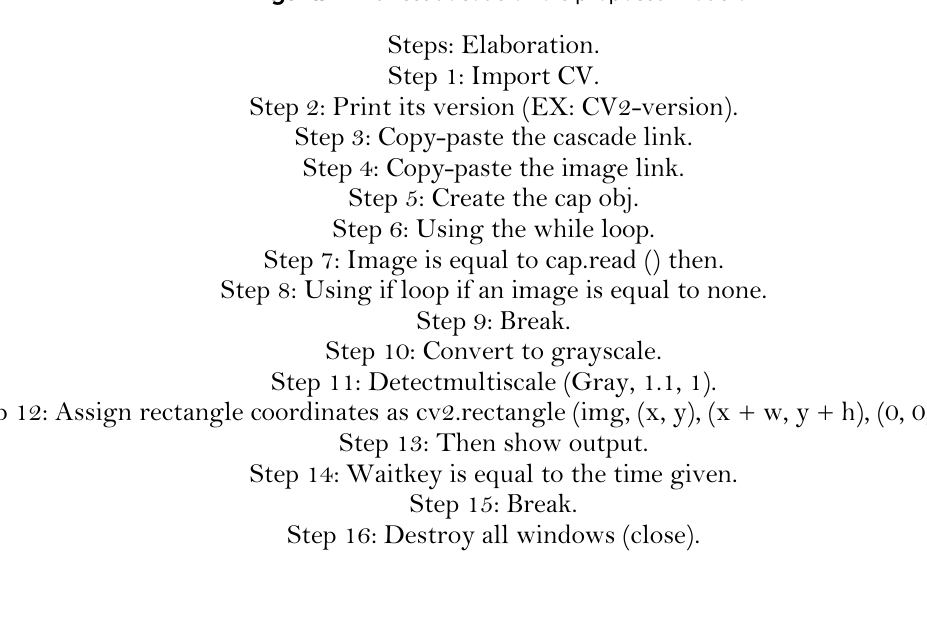
Algorithm 1. Pseudocode of the proposed model.